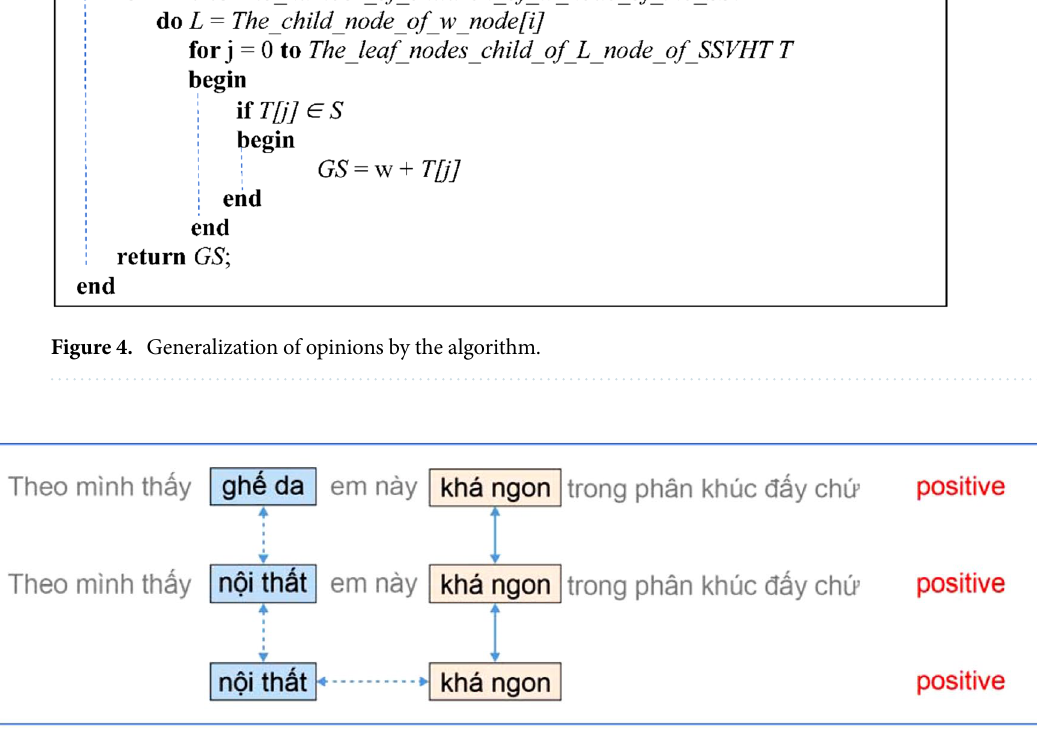
Figure 5. Image showing the relationship between the correlation aspect, the standard aspect, and the sentiment